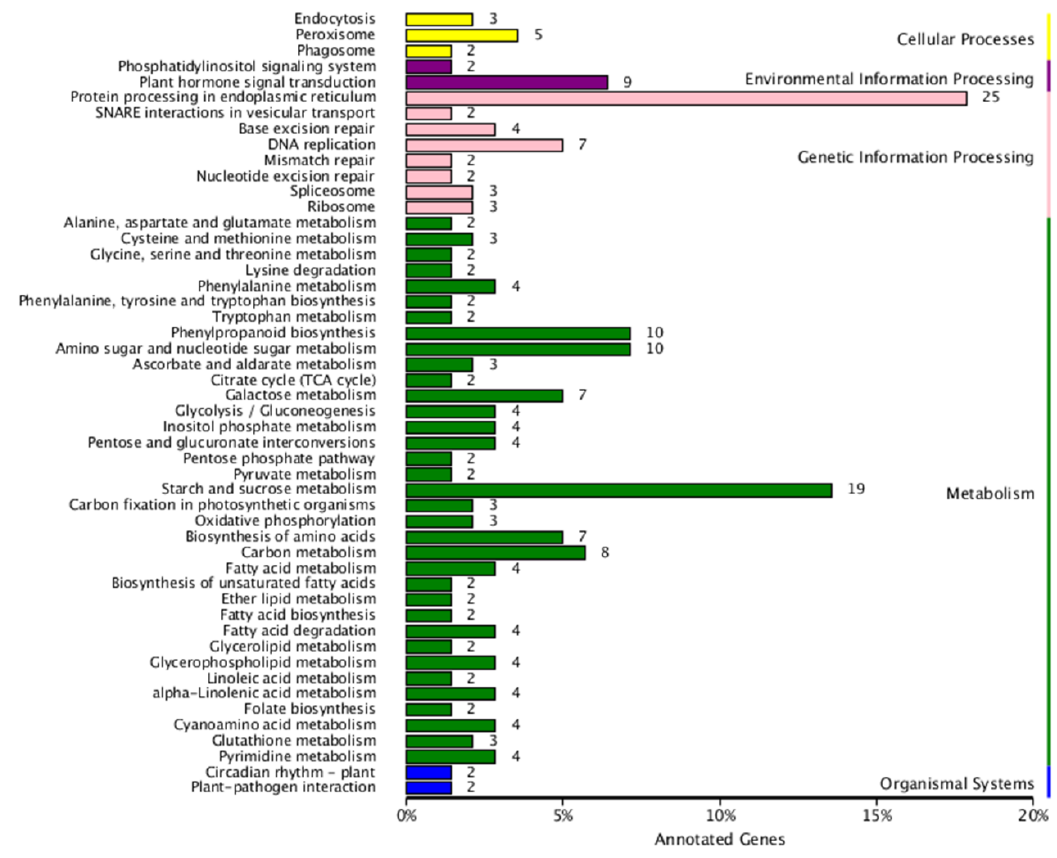
Figure 4. KEGG pathway assignment of the DEGs in S1 vs. S2 comparison group (top 50 pathways according to enrichment factor). S1 and S2 stand for the seed samples at pre-filling stage and filling stage, respectively.